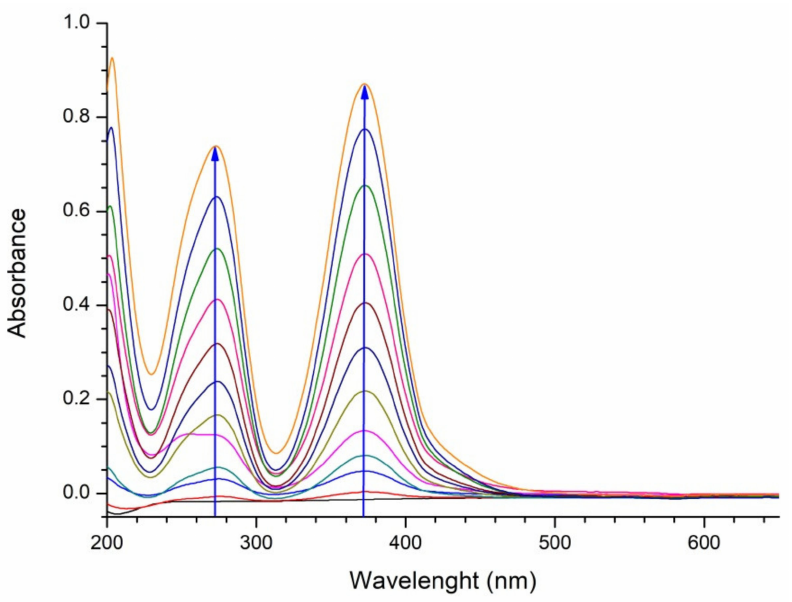
Figure 5. UV-Vis spectra of bare 0.1 M Na 2 SO 4 electrolyte during 180 min of electrolysis. Direction of evolution of spectra (increase of absorbance) is denoted by